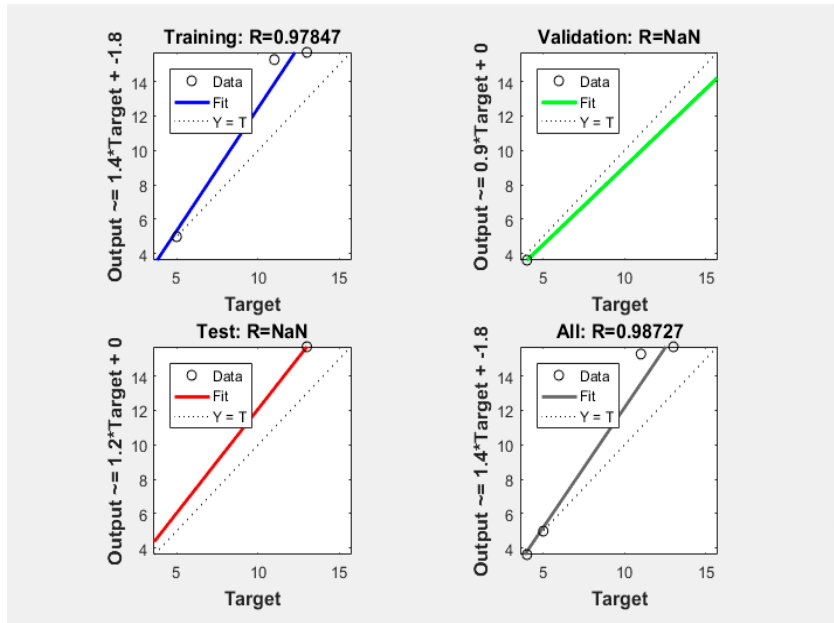
Figure 12 . Detail regression model generated during simulations. Figure 12. Detail regression model generated during